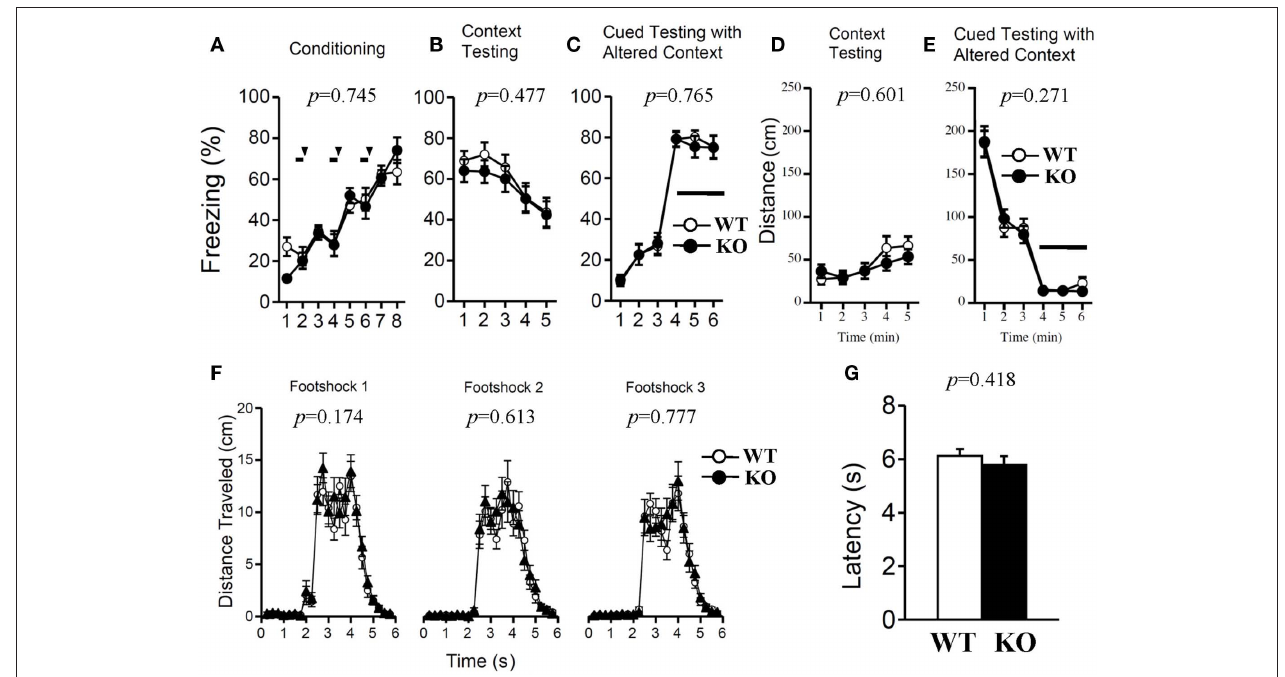
Figure 10 | Contextual and cued fear conditioning and hot plate test. Memory consolidation was assessed with contextual and cued fear conditioning tests. Wild-type ( n = 20) or relaxin-3 KO ( n = 20) mice were placed in a novel environment chamber for 8 min, where they received three electrical foot shocks. Freezing time (A) and distance traveled (F) were recorded. A tone was presented for 30 s (bars) followed by a 2-s foot shock (arrowheads). Twenty-four